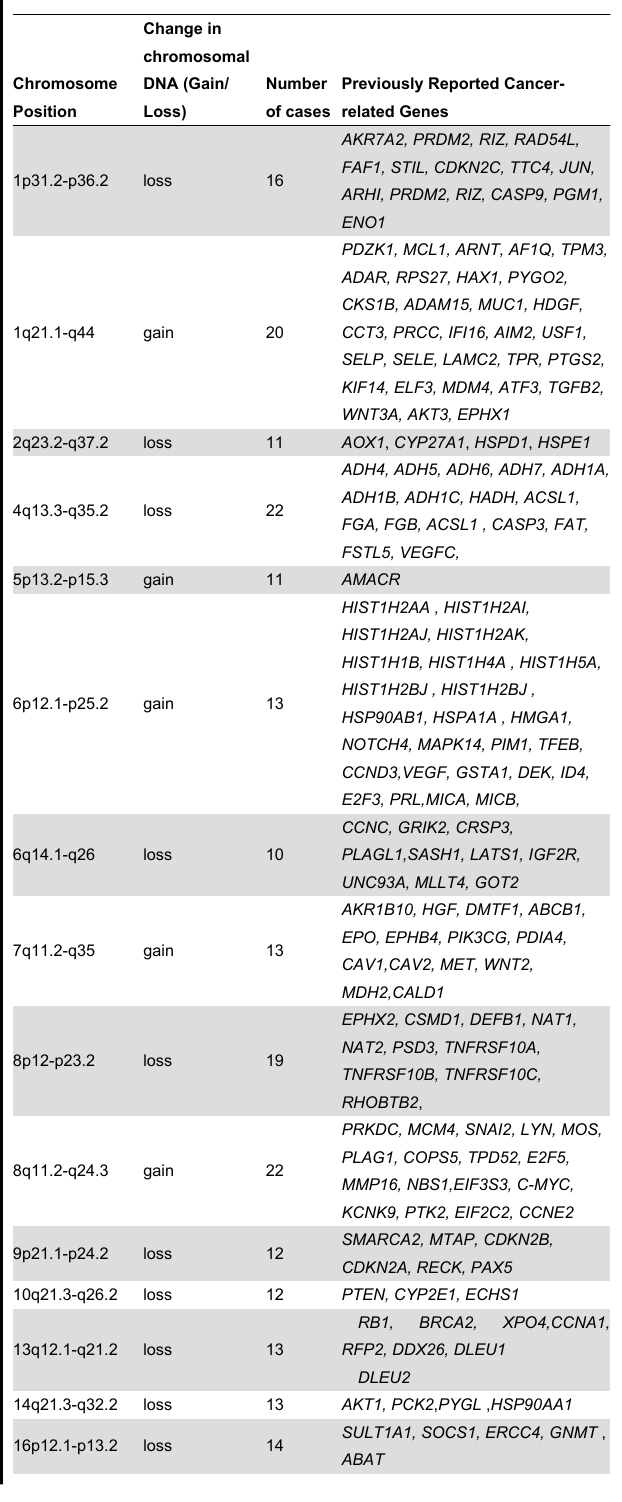
characteristics and RARs with tumor-free survival Univariate analysis found an association of tumor-free survival with tumor size, serum AFP ≥ 400 ng/mL, BCLC,